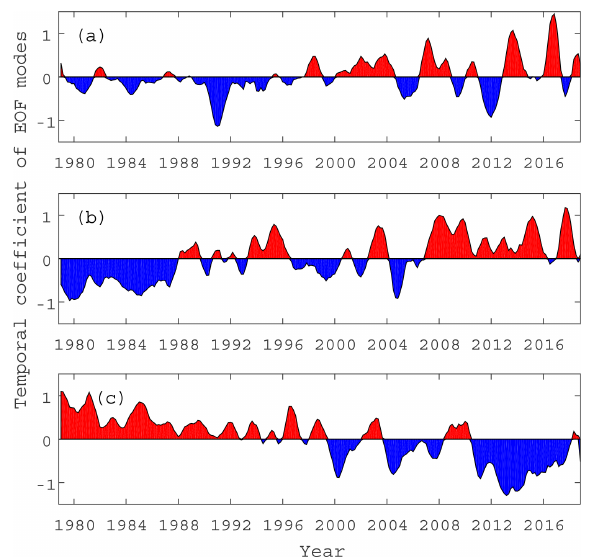
Figure 6. The corresponding EOF-based temporal coefficients of the Arctic sea ice motion in winter from 1979 to